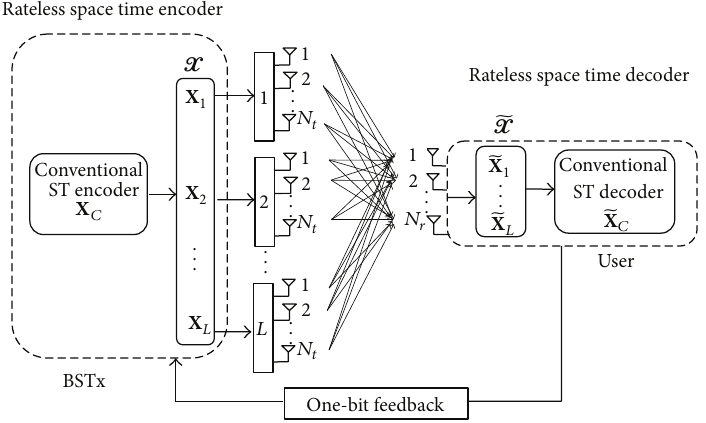
Figure 3: Rateless space time block code for single-user massive MIMO